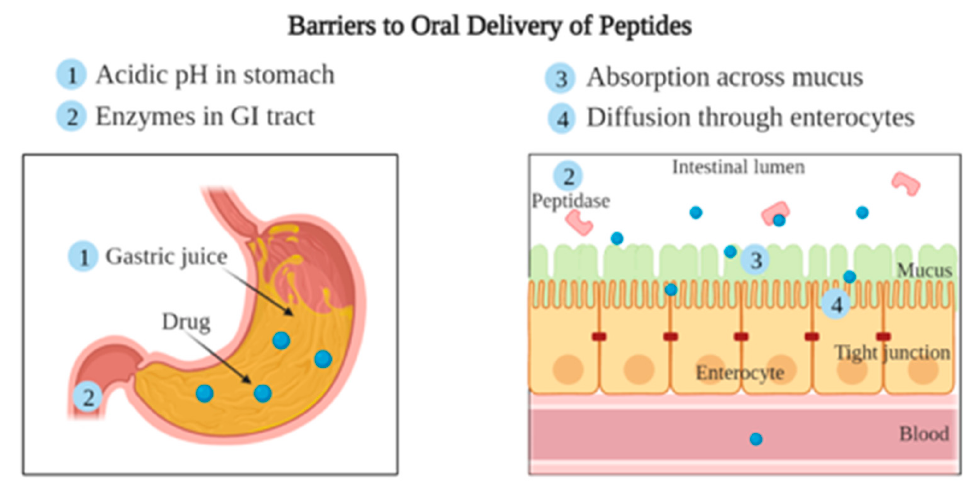
Figure 2. Barriers to oral delivery of peptides.